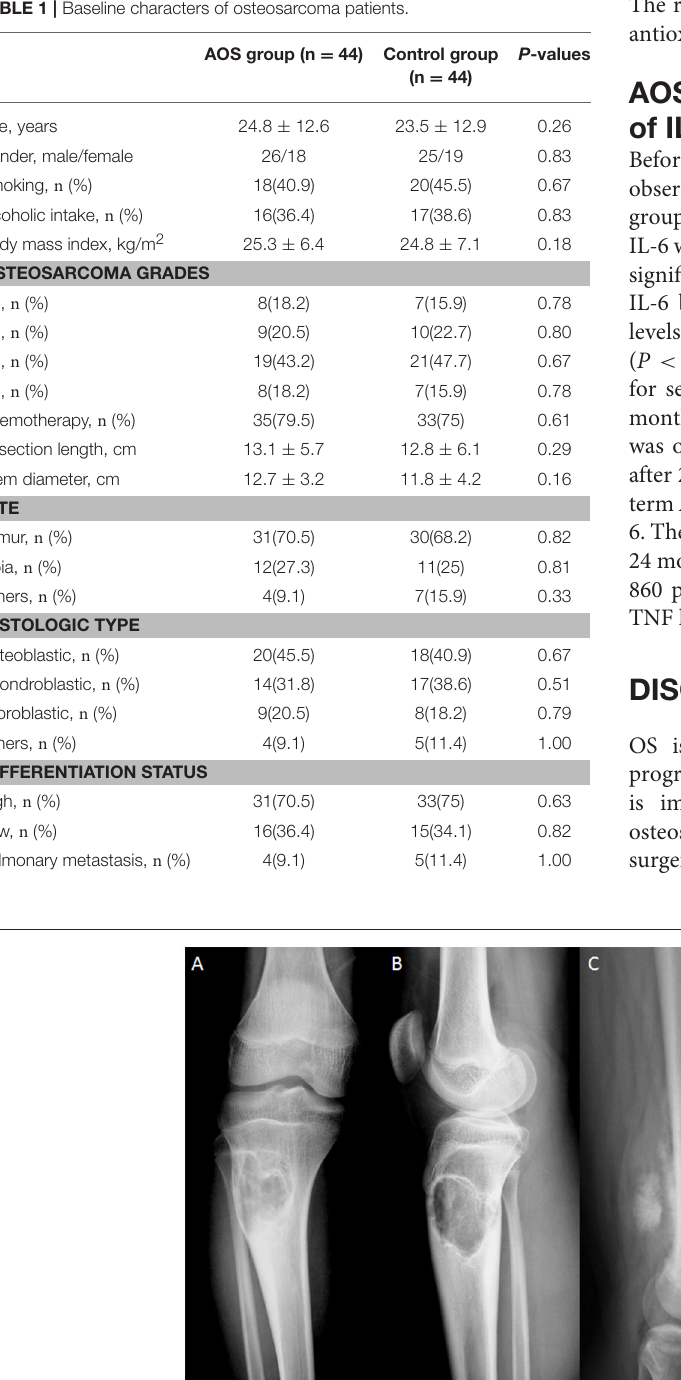
TABLE 1 | Baseline characters of osteosarcoma patients.